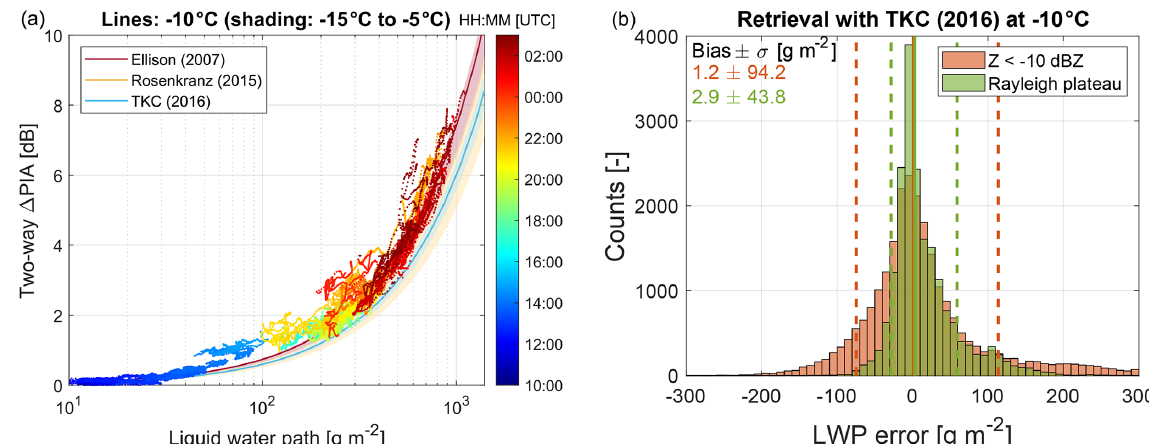
Figure 11. Scatterplot of the two-way (cid:49) PIA retrieved using the Rayleigh plateau technique as function of the LWP measured by the two- channel MWR (color of the points denotes time in UTC). (b) Statistics (probability density function, bias, and standard deviation) of the retrieved LWP for the corresponding time period using the Turner et al. (2016) model at − 10 ◦ C for the traditional reflectivity threshold and the Rayleigh plateau method using the two-channel MWR as a